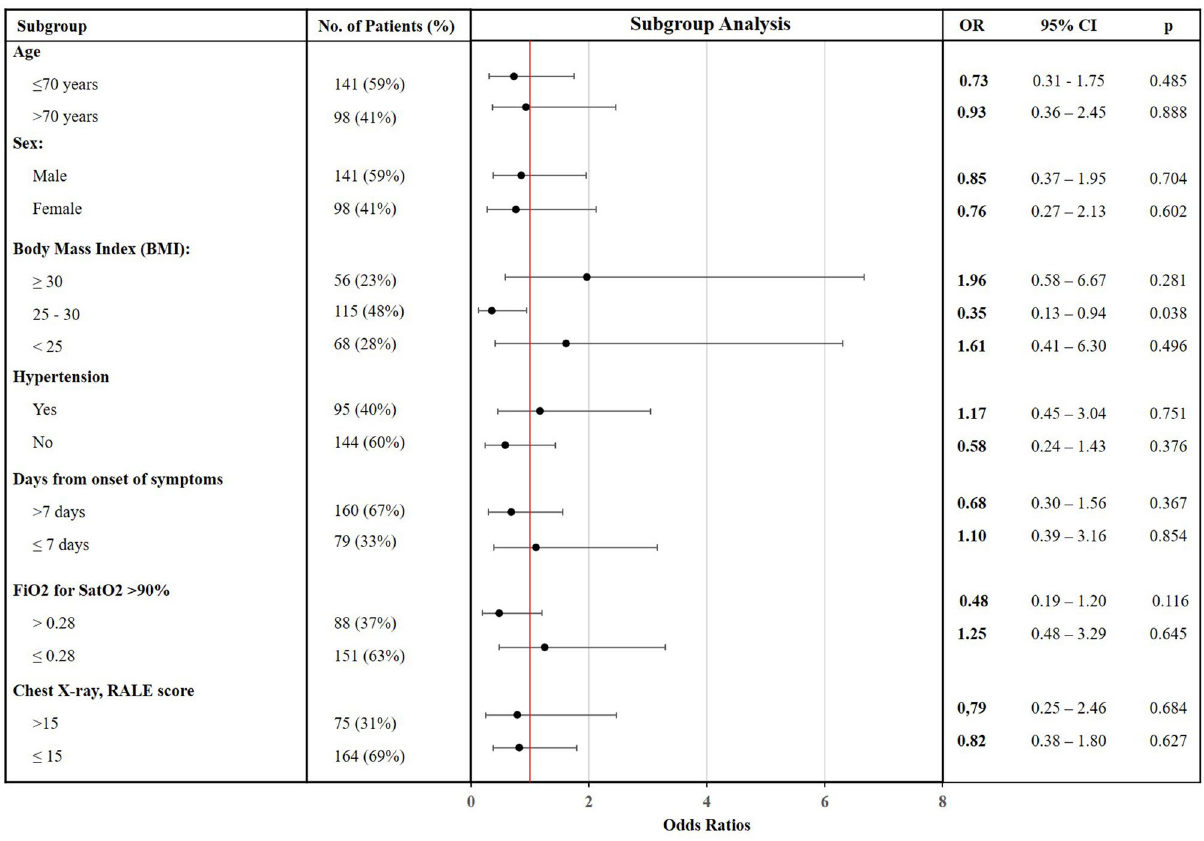
Figure 2. Forest plot for the effect of colchicine on the composite outcome in prespecified subgroups. OR odds ratios, 95% CI 95% confidence